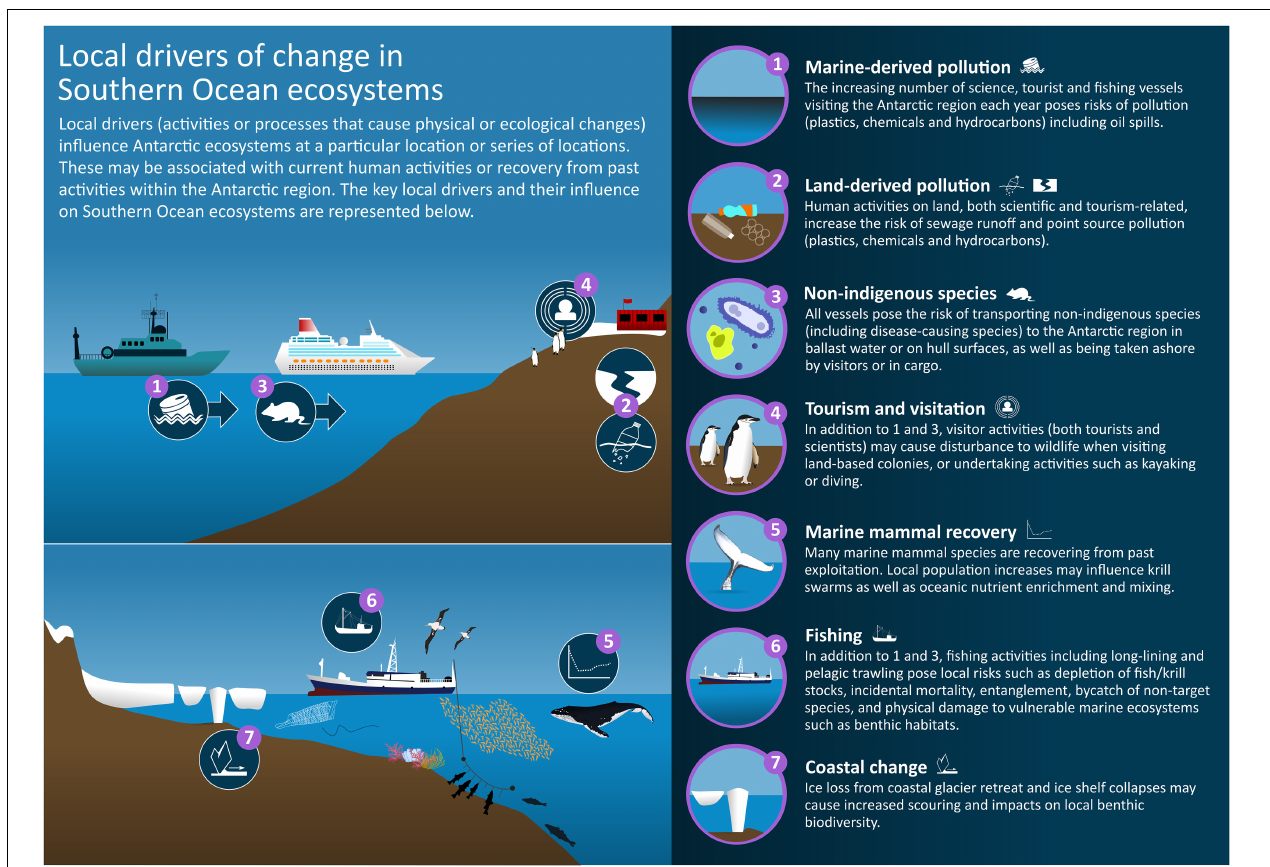
FIGURE 1 | Summary of local drivers of change influencing Southern Ocean